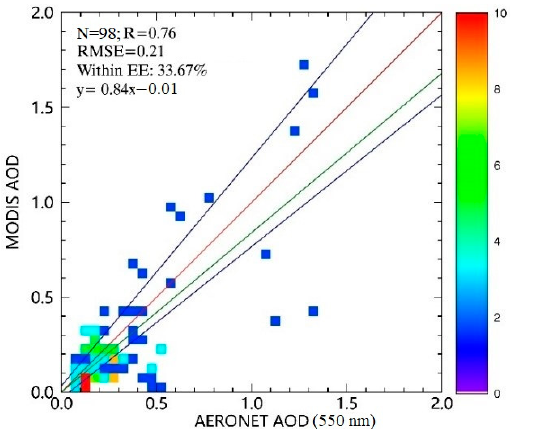
Figure 5. Comparison Between MODIS DB AOD and AOD Measured by AERONET Stations.